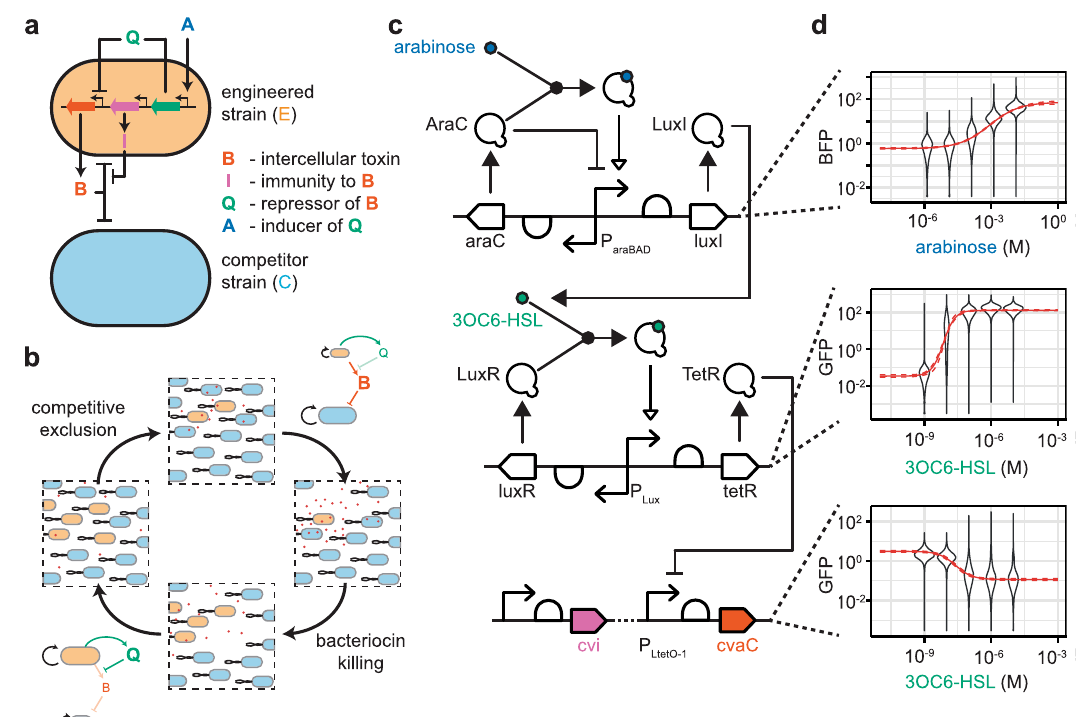
Fig. 6 Autonomous control of bacteriocin production. a The engineered strain produces its own quorum molecule at a rate that is tunable by arabinose induction. b Bacteriocin production is turned off when the engineered population density is high, allowing the competitor to grow, and competitive exclusion to complete the cycle. c The system was constructed in three parts: arabinose inducible expression of LuxI, 3OC6-HSL inducible expression of TetR, and TetR repressible expression of microcin-V. d Each part was characterised by cloning a fl uorescent reporter protein (GFP or BFP) downstream of the relevant promoter and measuring expression using fl ow cytometry. Hill functions were fi tted to the data using a Bayesian method. Violins show the distribution of all fl ow cytometry events from three replicates. The solid lines = mean prediction, dashed lines = 95% credible region in the mean.